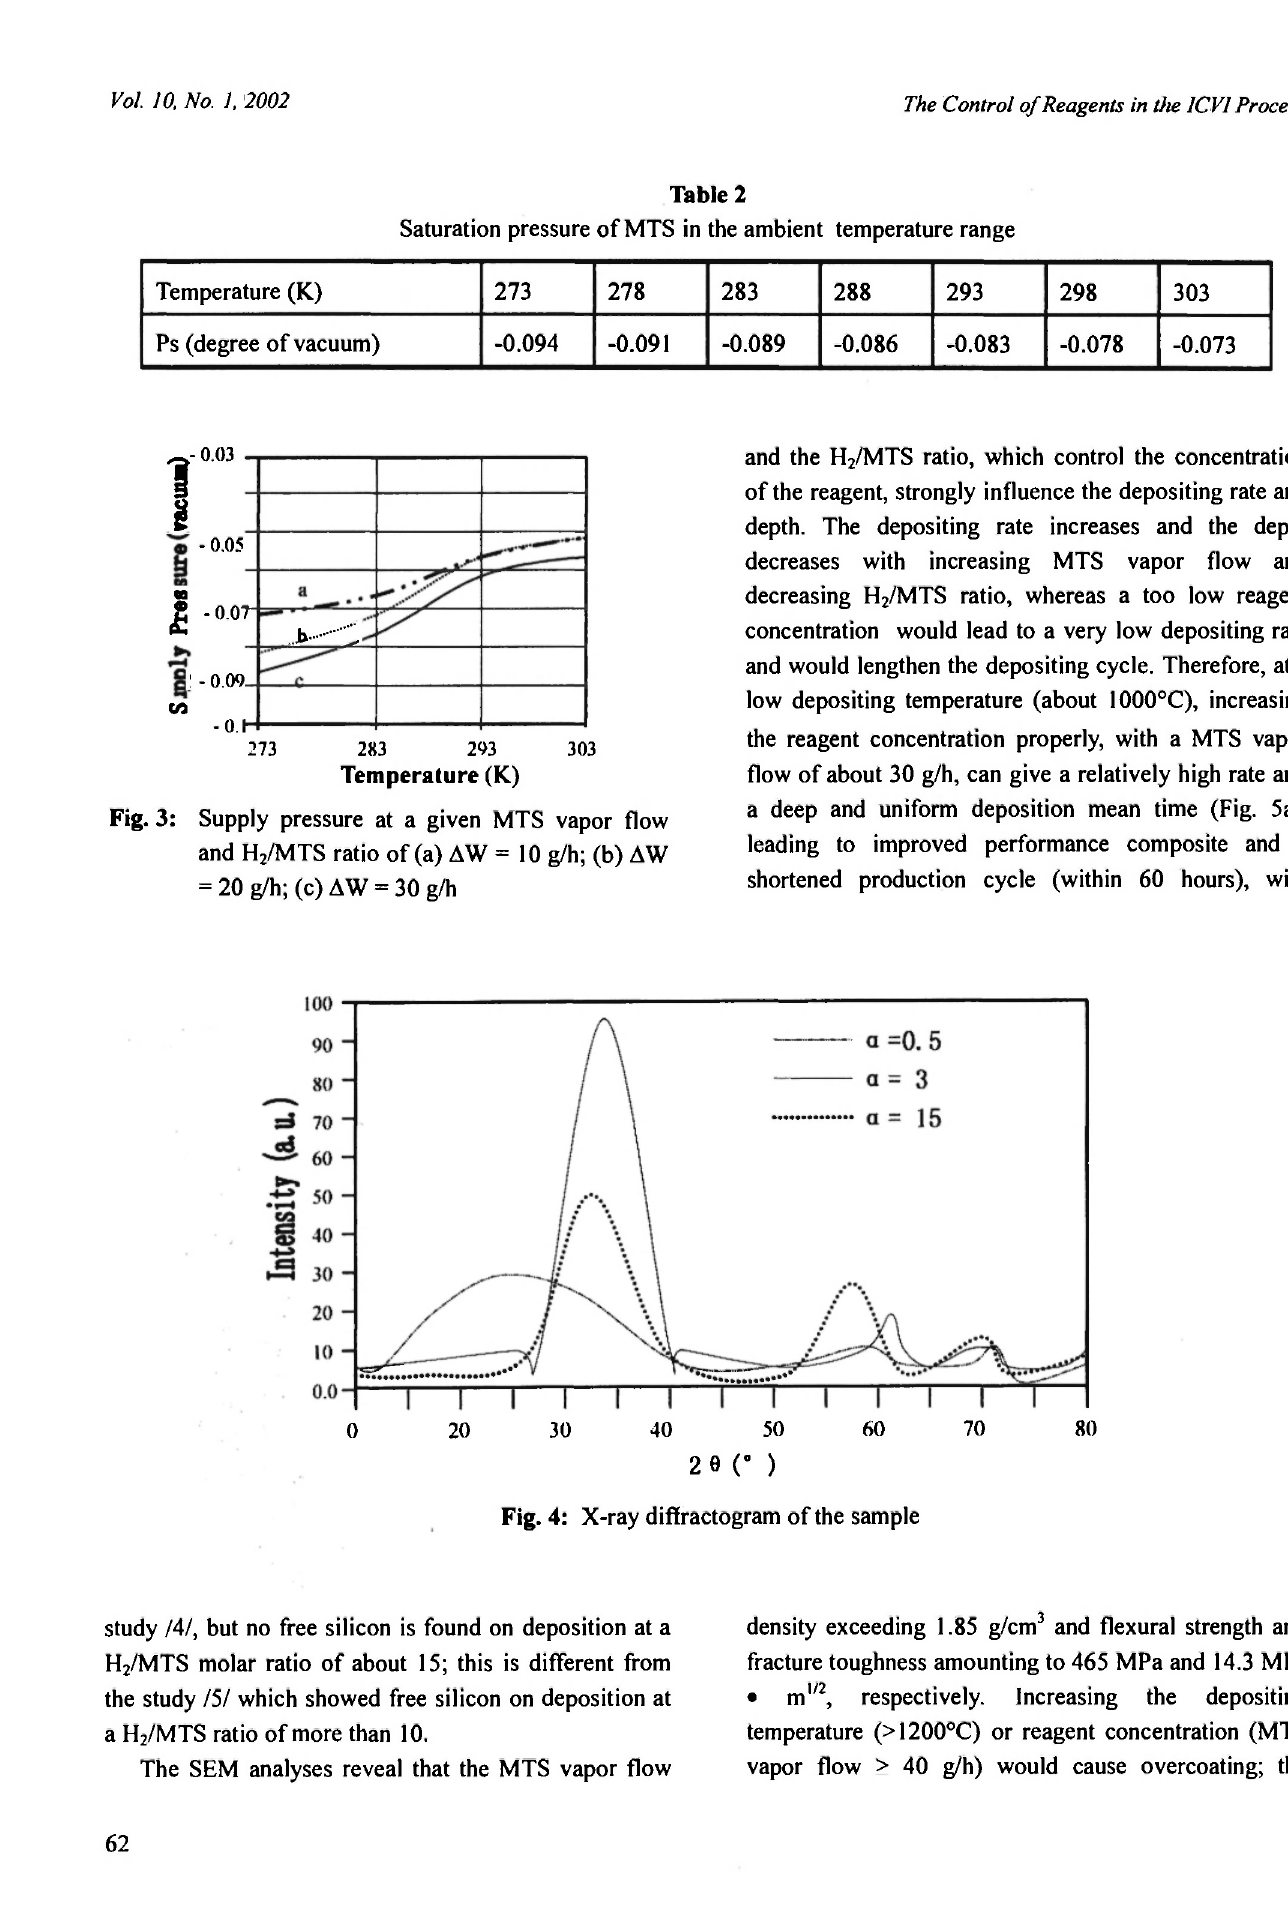
density exceeding 1.85 g/cm 3 and flexural strength and fracture toughness amounting to 465 MPa and 14.3 MPa • m' /2 , respectively. Increasing the depositing temperature (>1200°C) or reagent concentration (MTS vapor flow > 40 g/h) would cause overcoating;